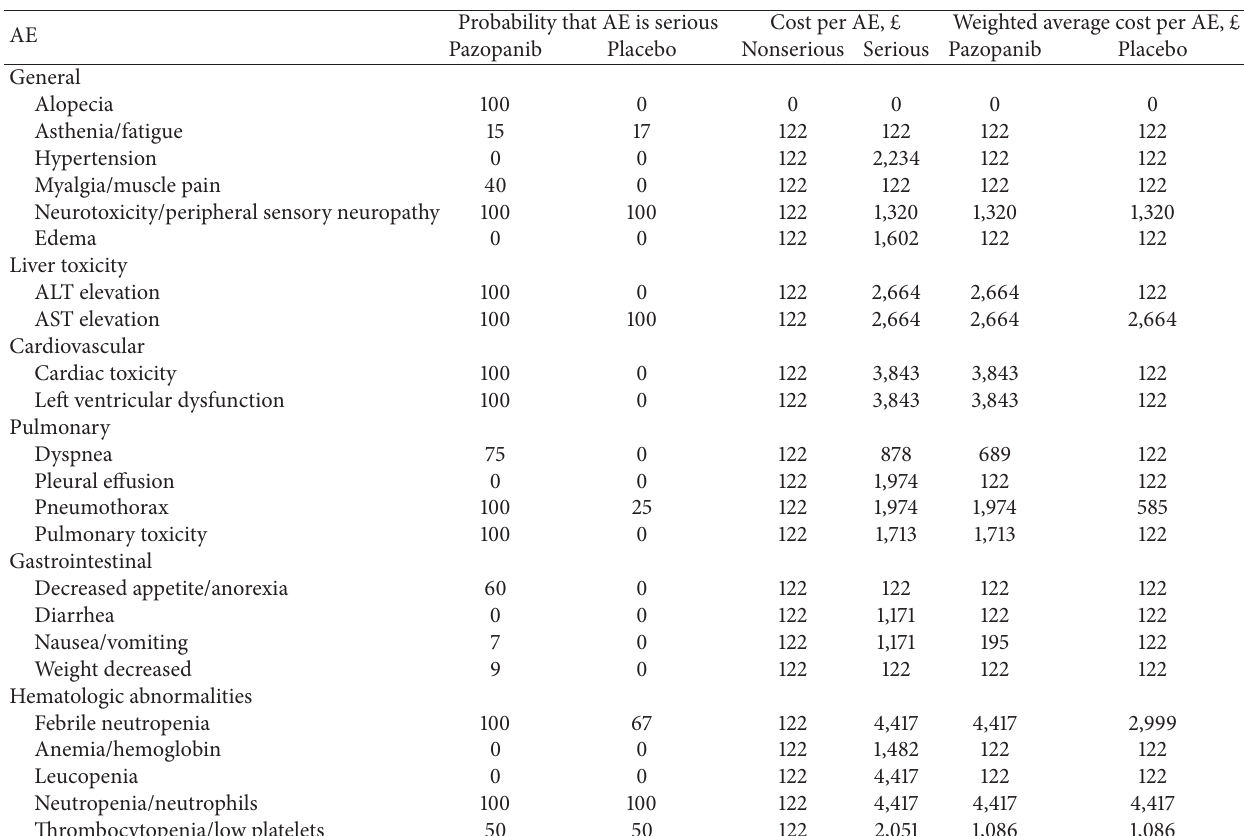
Table 9: Costs of adverse